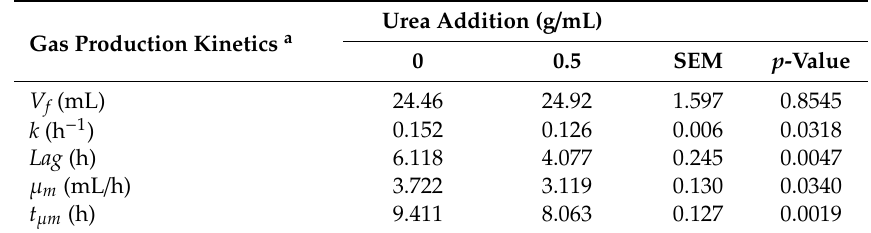
Table 3. E ff ect of urea addition in the bu ff er on gas production kinetics of fenugreek seed gum in 28 h in vitro incubations with caecal inoculum (n = 9 for each